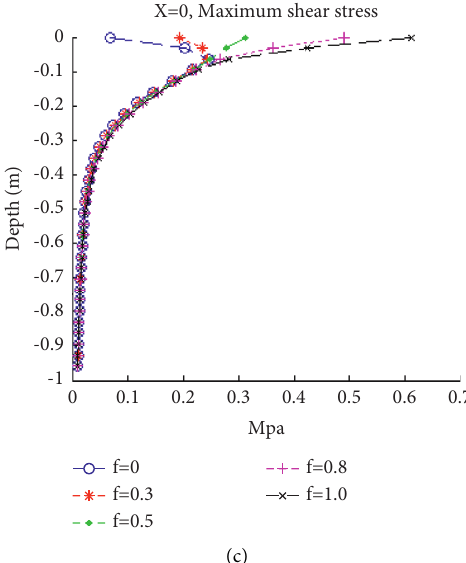
Figure 13: Calculation result of center point principal stress of single circular load in z -axis ( x � 0). (a) Calculation result of center point maximum principal stress of single circular load in z -axis ( x � 0). (b) Calculation result of center point third primary stress of single circular load in z -axis ( x � 0). (c) Calculation result of center point maximum shear stress of single circular load in z -axis ( x �